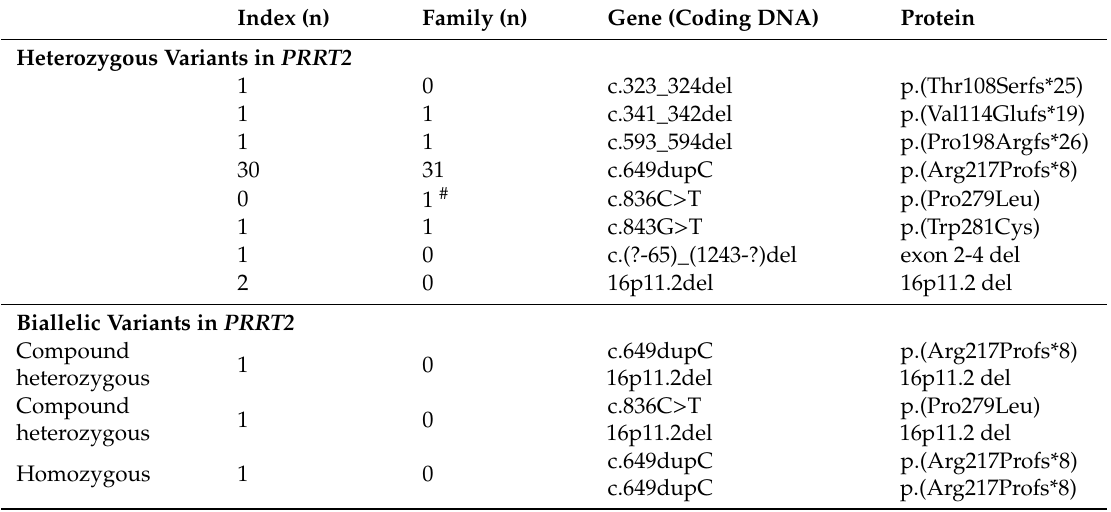
Table 2. Genetic variants of 40 index cases (core cohort) and familial cases from the extended cohort.